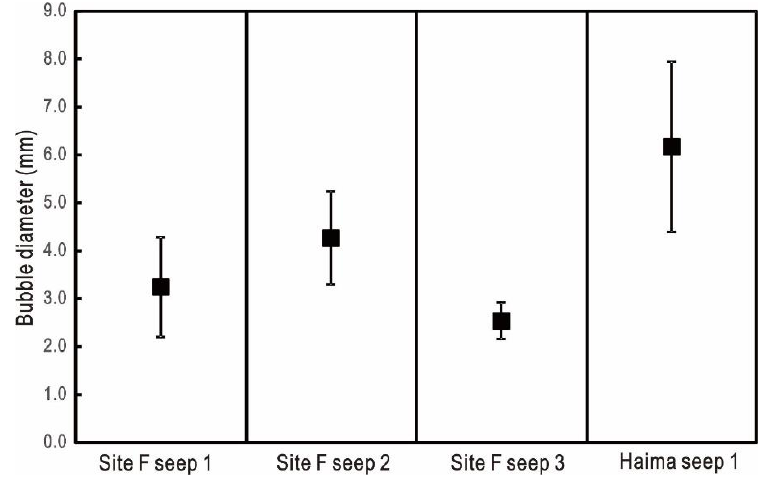
Figure 4. Individual size distributions of gaseous bubbles for the four seep vents. A smooth kernel distribution was used to fit the histogram, where n is the number of bubbles measured.